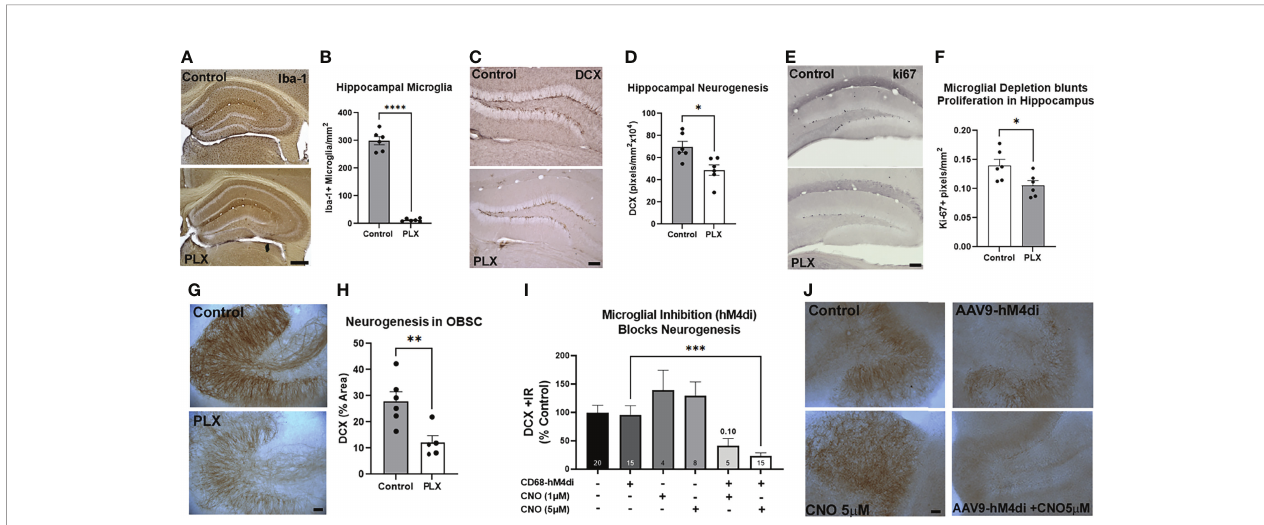
FIGURE 1 | Microglia at rest promote adult hippocampal neurogenesis. (A-F) Adult mice were given either normal or PLX-5622-supplemented chow for 3 weeks to deplete microglia. (A) PLX chow caused robust depletion of microglia as measured by Iba-1 IHC. (B) Quanti fi cation of Iba-1 staining in hippocampus found ~96% depletion of microglia. **** p < 0.0001, t- test vs. control. Scale bar: 500µm (C) Representative images of DCX staining in hippocampal dentate gyrus showing loss of neurogenesis with microglial depletion. Scale bar 100 µm. (D) Quanti fi cation found a ~30% reduction in DCX immunoreactivity. * p < 0.05, t- test vs. control. (E) Representative images of ki67 immunostaining after EtOH in dentate regions of the hippocampus in control and microglia depleted (PLX) mice. (F) Ethanol caused a 24% reduction in ki67. * p < 0.05, t- test. (G, H) OBSC were treated with PLX-3397 (1µM) for 10 days to deplete microglia and determine its effect on neurogenesis. (G) Representative images of DCX in hippocampal region of OBSC showing loss of neurogenesis with microglial depletion. Scale bar: 100µm. (H) Quanti fi cation found a 56% reduction in DCX staining with microglial depletion. ** p < 0.01, t- test vs. control. (I, J) Microglial inhibition reduces neurogenesis. OBSC were treated with either AAV9.CD68.hM4di or AAV9.EGFP control for 24 hours prior to treatment with CNO (1µM or 5µM) or vehicle for 4 days, followed by IHC for DCX. (I) Quanti fi cation of DCX found that neither viral transfection alone nor CNO alone signi fi cantly altered neurogenesis. Addition of CNO to microglial hM4di-transfected slices caused a 77% reduction in DCX with 5µM CNO. 1-Way ANOVA, F 5,61 = 7.148, p< 0.0001. *** p < 0.001, Sidak ’ s post-hoc test vs. AAV9.CD68.hM4di alone (J) Representative images of DCX +/- CNO and AAV9 transfection. Scale bar: